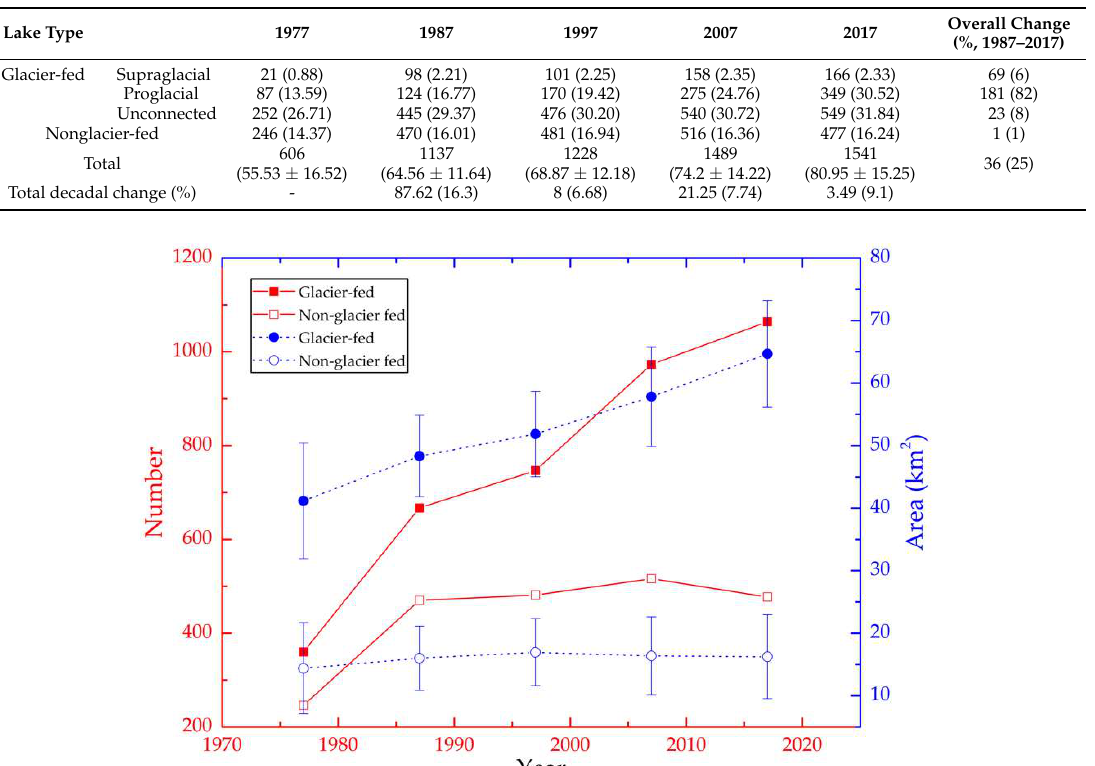
Figure 5. Changes in the total number and surface area of glacier-fed and nonglacier-fed lakes over time in Nepal.